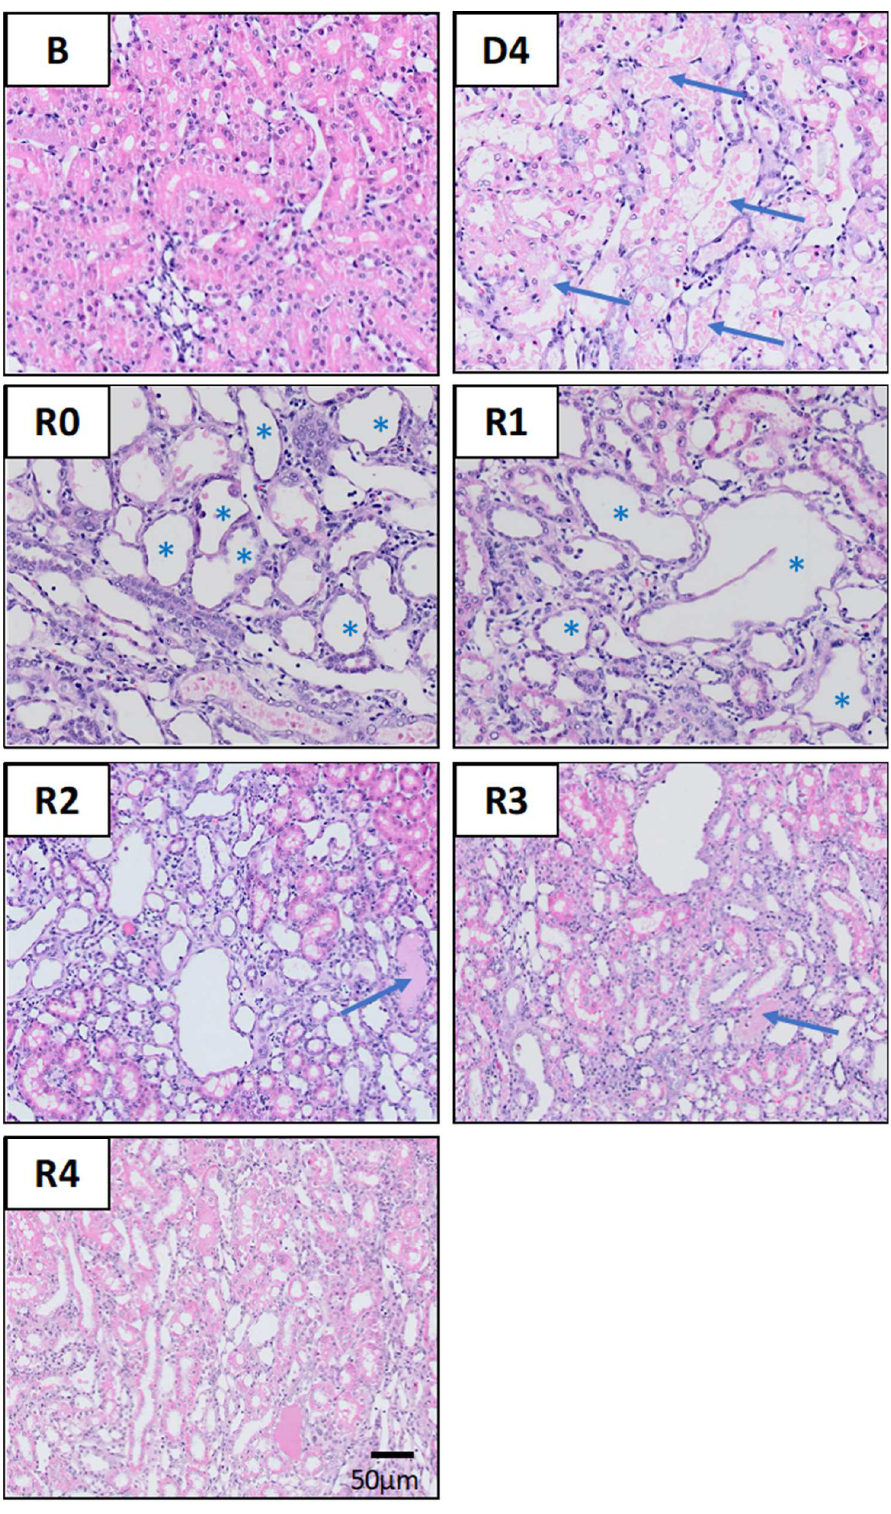
Figure 3. Renal histology. Representative images of kidney specimens stained with haematoxylin and eosin (HE) at different time points of AKI evolution. ( B ): basal; ( D4 ): day of maximum kidney damage after cisplatin treatment; ( R0 ): day of recovery; ( R1 ): 1 week after recovery; ( R2 ): 2 weeks after recovery; ( R3 ): 3 weeks after recovery; ( R4 ): 4 weeks after recovery. Arrows in D4 indicate widespread detachment of necrotic tubular epithelial cells. Asterisks in R0 and R1 indicate tubular dilatation. Arrows in R2 and R3 indicate intratubular casts.